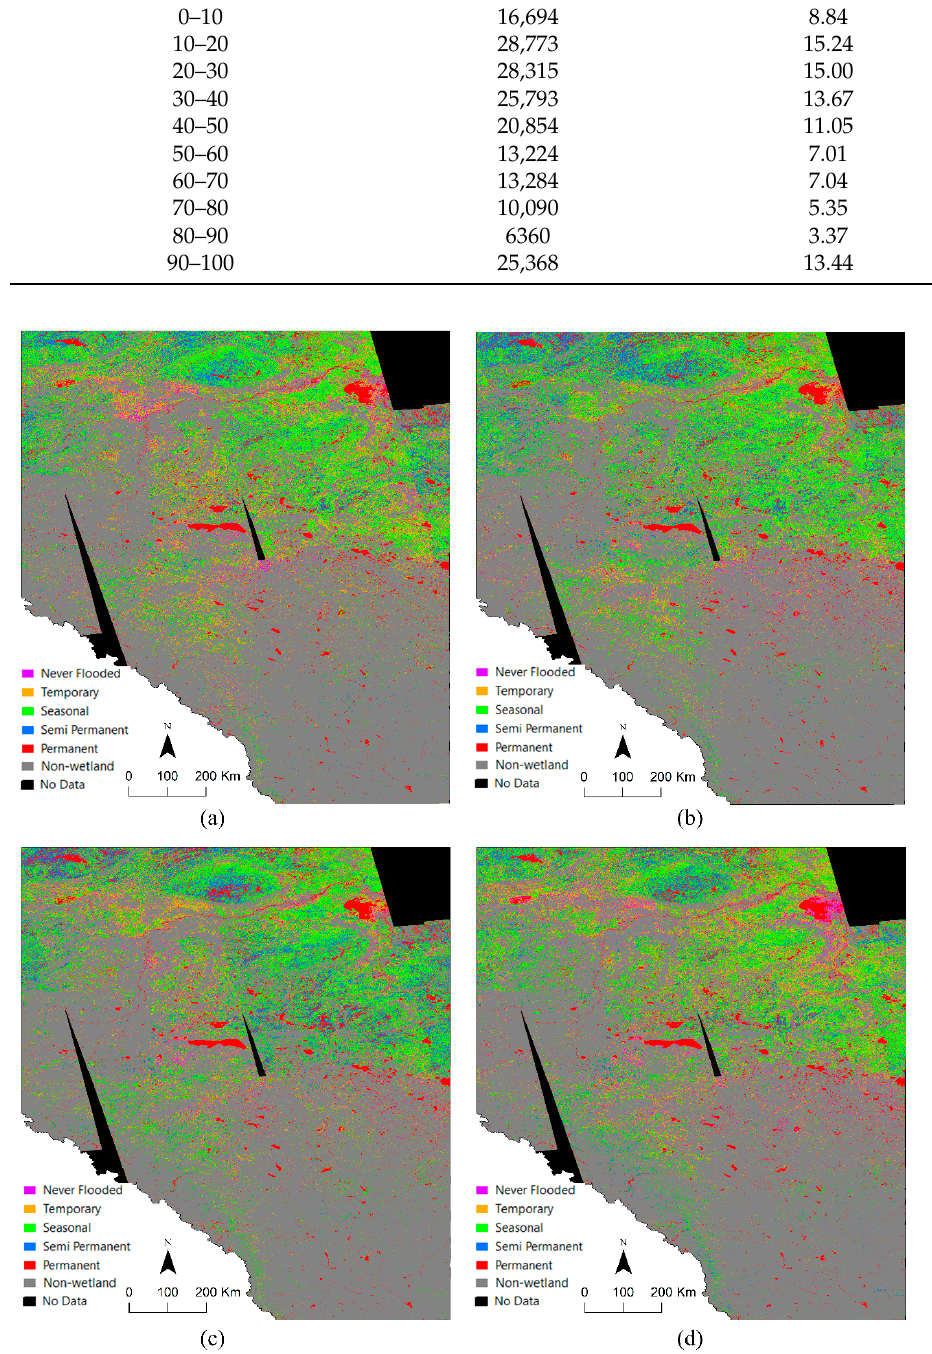
Figure 8. Wetland hydroperiod classification for the entirety of Alberta using coherence maps produced in ( a ) 2017; ( b ) 2018; ( c ) 2019; ( d ) 2020.